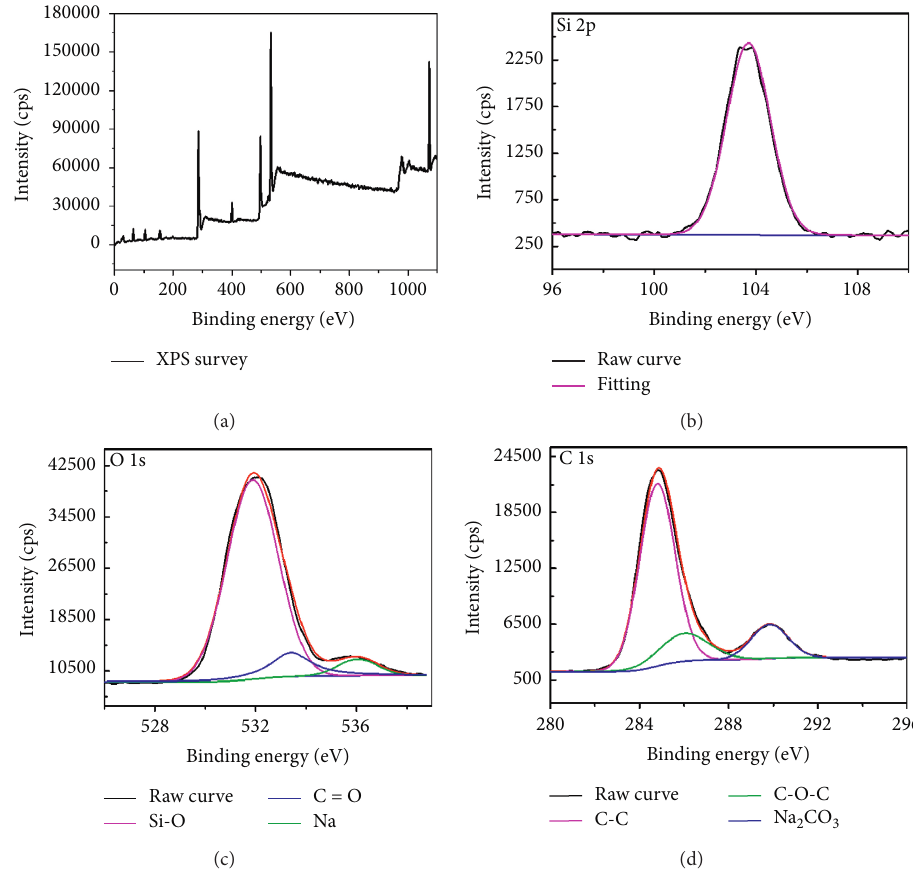
Figure 8: XPS spectra of the C7-1% sample.